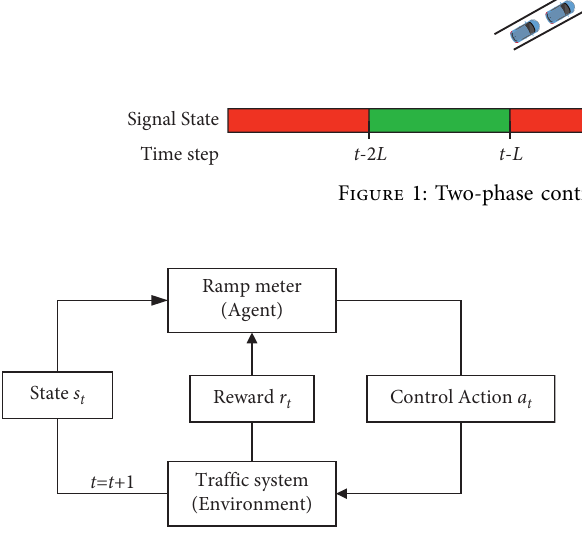
Figure 2: Ramp metering in the general scheme of